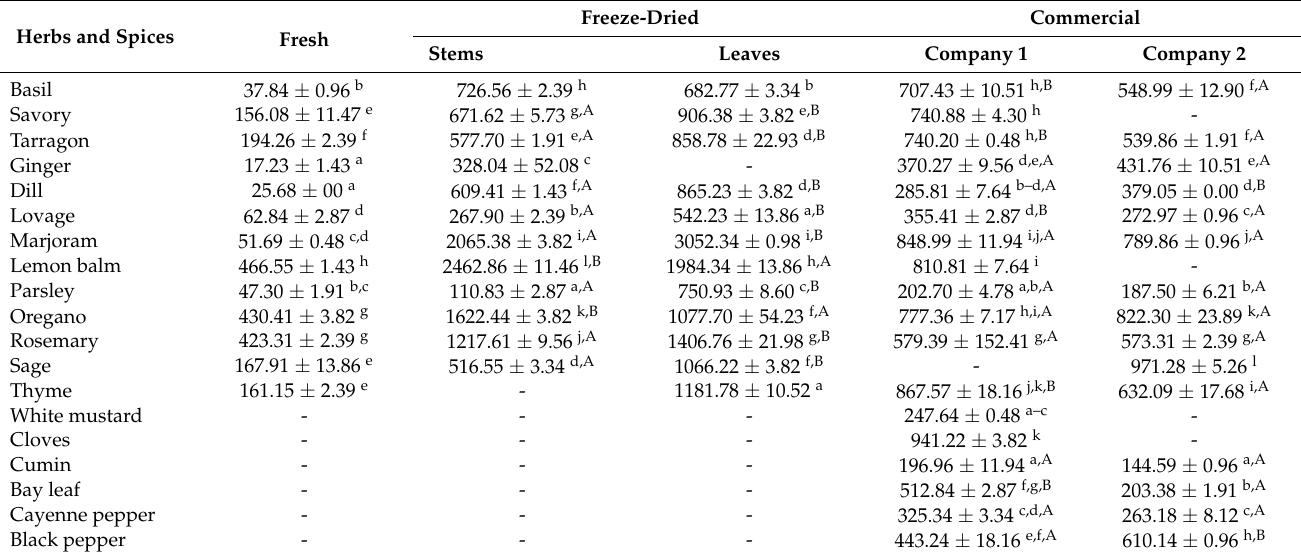
Table 1. The content of total polyphenols in herbs and spices (mg CAE/100 g).